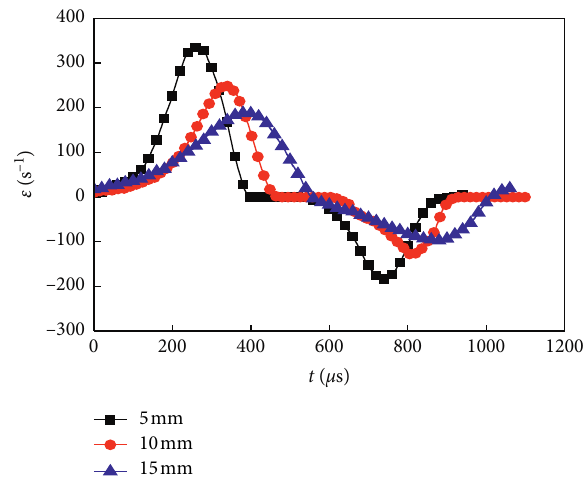
Figure 3: Influence of waveform shaper diameter on waveform.